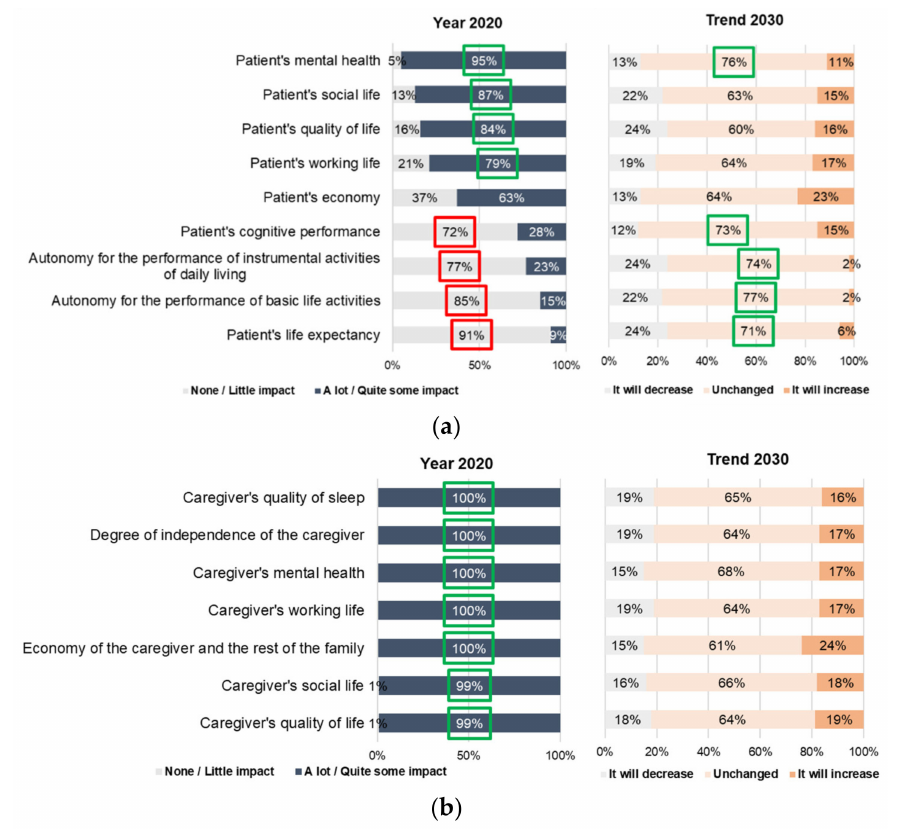
Figure 2. Impact of PD on patients and caregivers: ( a ) Impact of PD on patients (PD in early stages); ( b ) Impact of PD on caregivers.